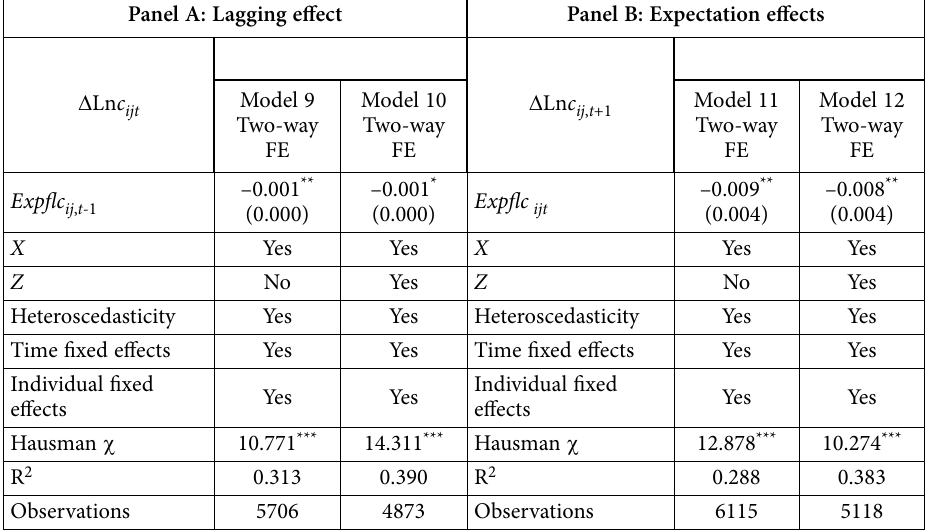
Table 7. Estimation results of lag effect and expected effect Panel A: Lagging